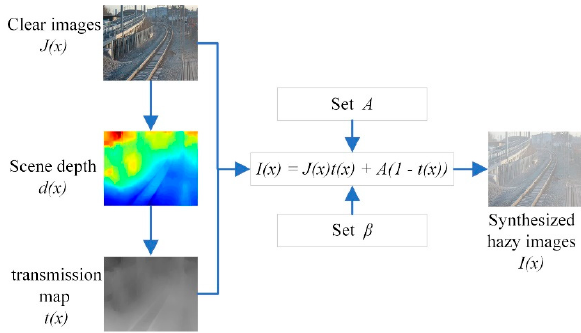
Figure 5. The process of synthesizing railway hazy images.